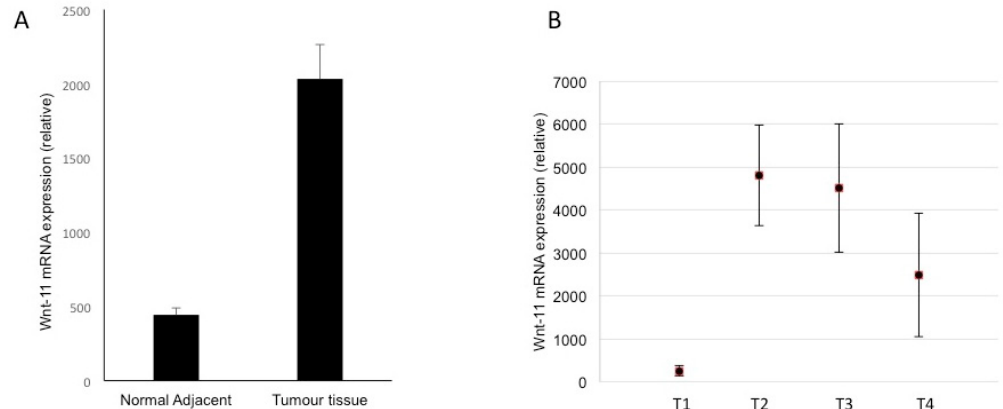
Figure 4. Clinical evidence that Wnt-11 was significantly upregulated in a cohort of pancreatic tumour samples. ( A ) In total, 111 pairs of tumour and adjacent control tissues were studied and Wnt-11 expression (relative) appeared to be increased in the tumour tissue compared to adjacent normal tissues ( p = 0.02). ( B ) A high level of Wnt-11 expression (relative) was found in patients classified according to T staging ( p < 0.05 for T1 vs T2 or T3 or T4; T2 vs T3 or T3 vs T4 p > 0.05). All data were analysed as means ± standard errors.